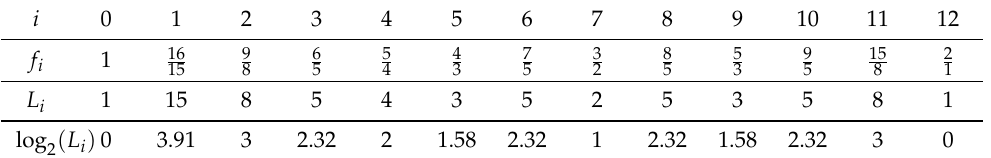
Table 1. Frequencies and periodicites relative to pitch 0.